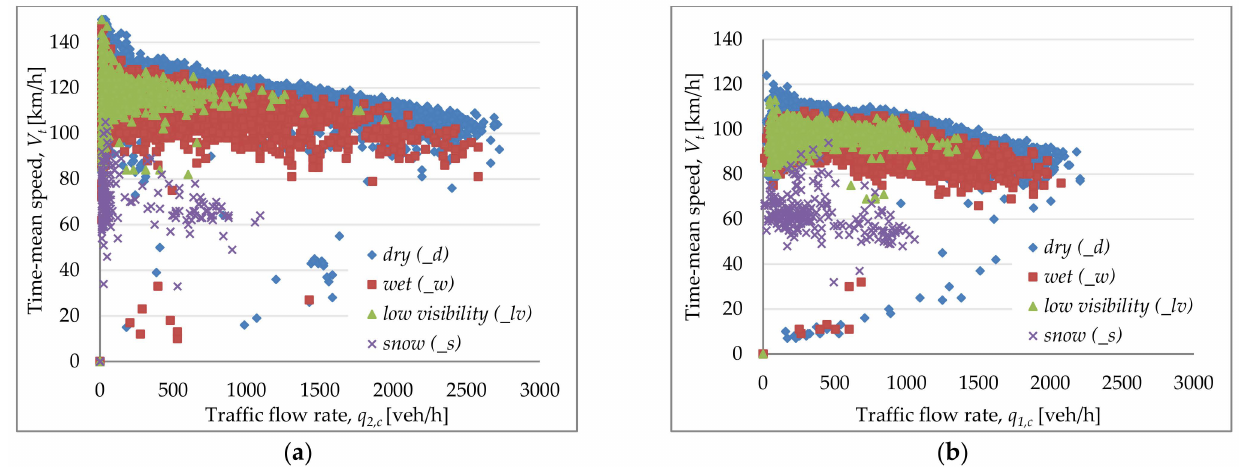
Figure 2. Example of scatter graph of time mean speed vs. traffic flow rate on the carriageway near Ljubljana in different traffic lanes: ( a ) lane 2—left (overtaking) lane; ( b ) lane 1—right